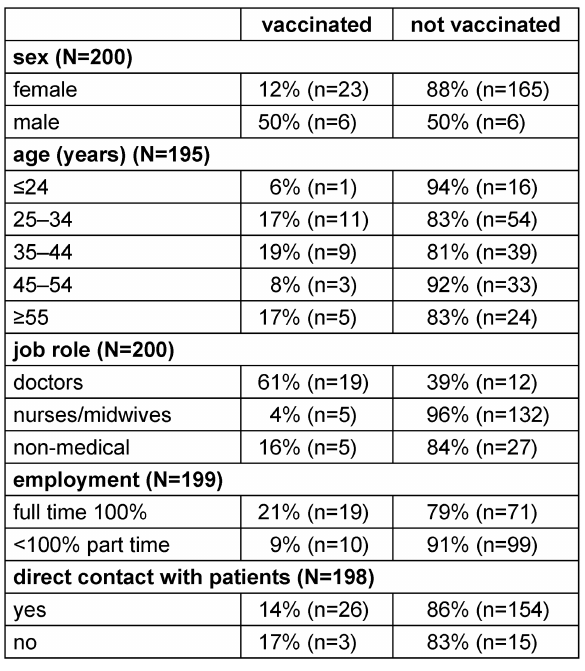
Table 1: Characteristics of vaccinated and not vaccinated